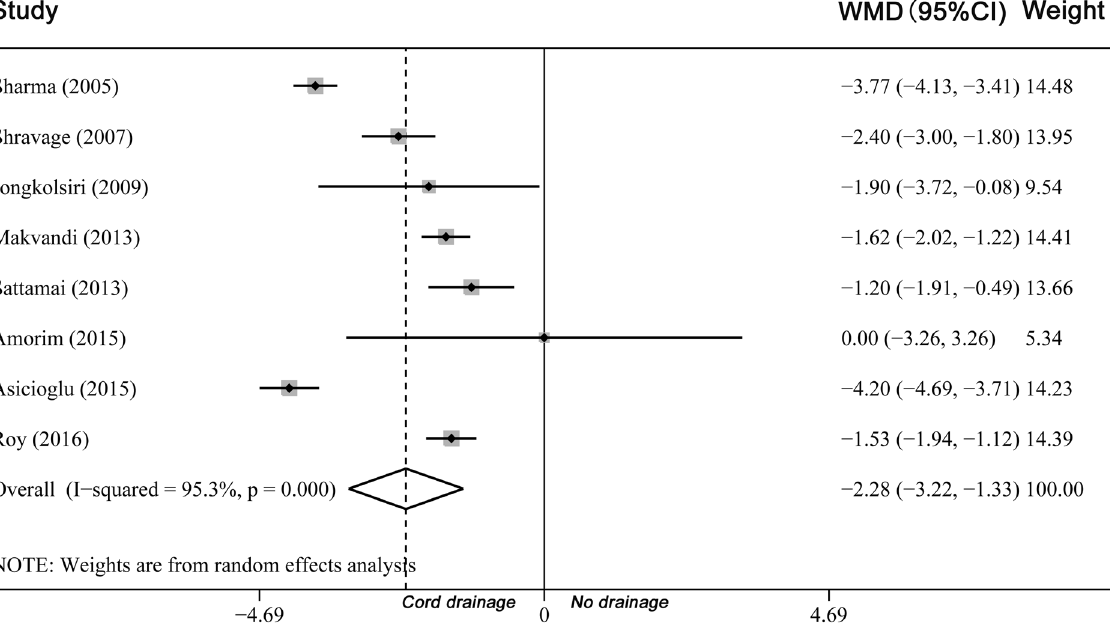
Figure 3. Comparison of cord drainage versus no drainage (all). Outcome: Length of the third stage of labour.